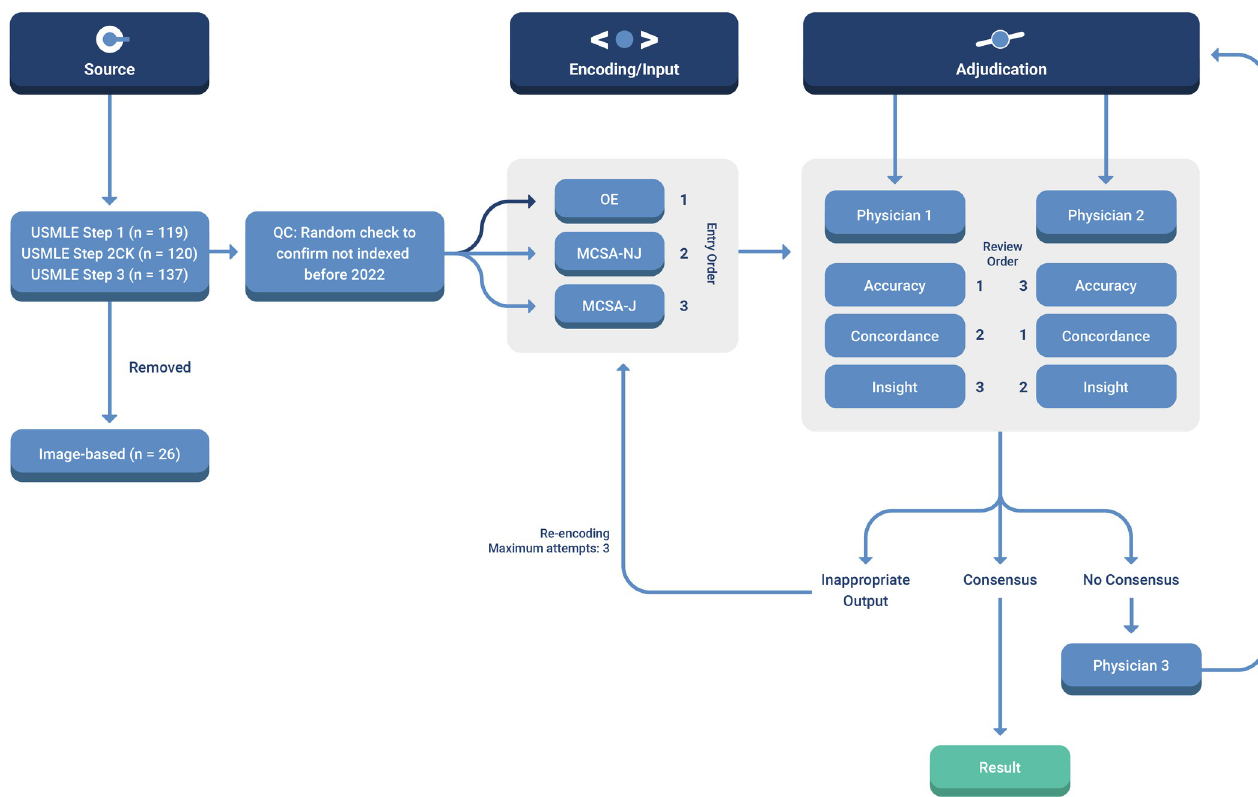
Fig 1. Schematic of workflow for sourcing, encoding, and adjudicating results. Abbreviations: QC = quality control; MCSA-NJ = multiple choice single answer without forced justification; MCSA-J = multiple choice single answer with forced justification; OE = open-ended question